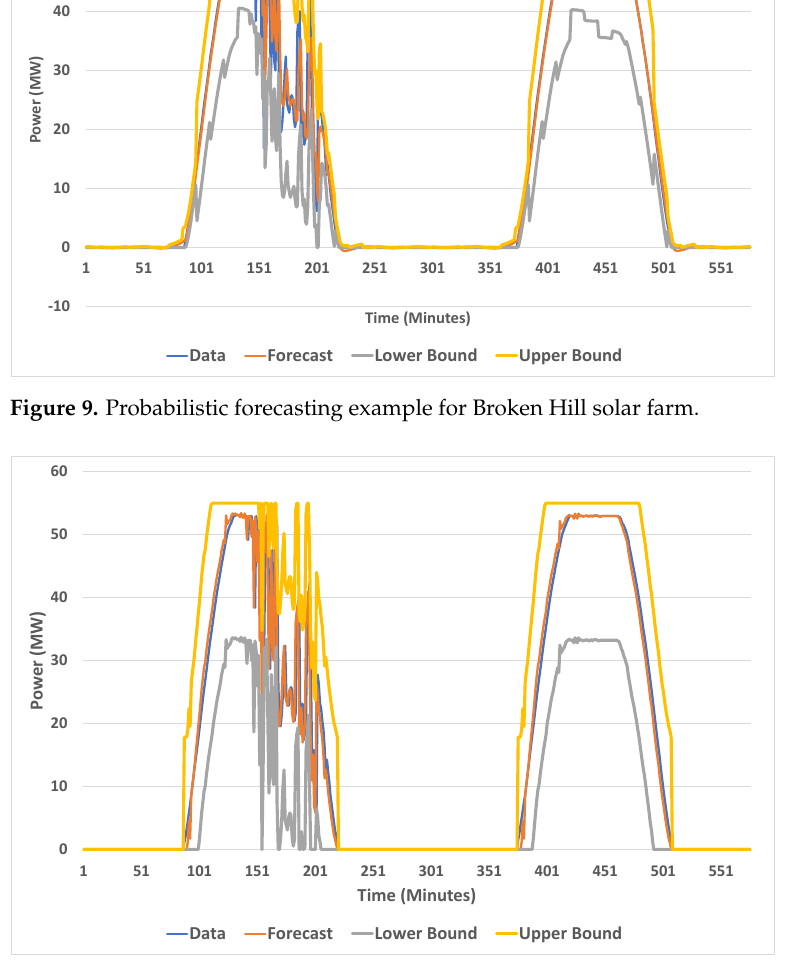
Figure 10. Probabilistic forecasting example for Broken Hill solar farm with smart persistence.